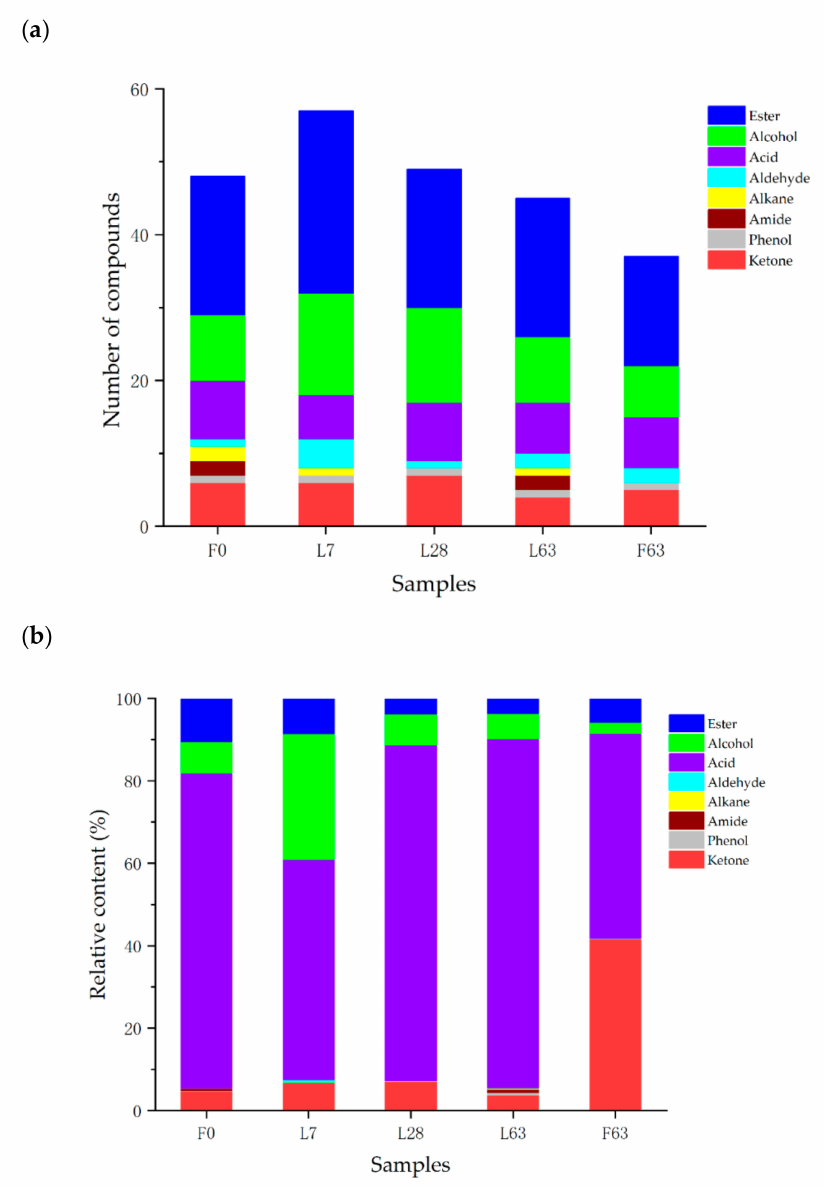
Figure 3. Volatile compounds identified by SPME-GC–MS of noni juice with different fermentation times and scales. ( a ) Number of volatile compounds. ( b ) Relative content of volatile